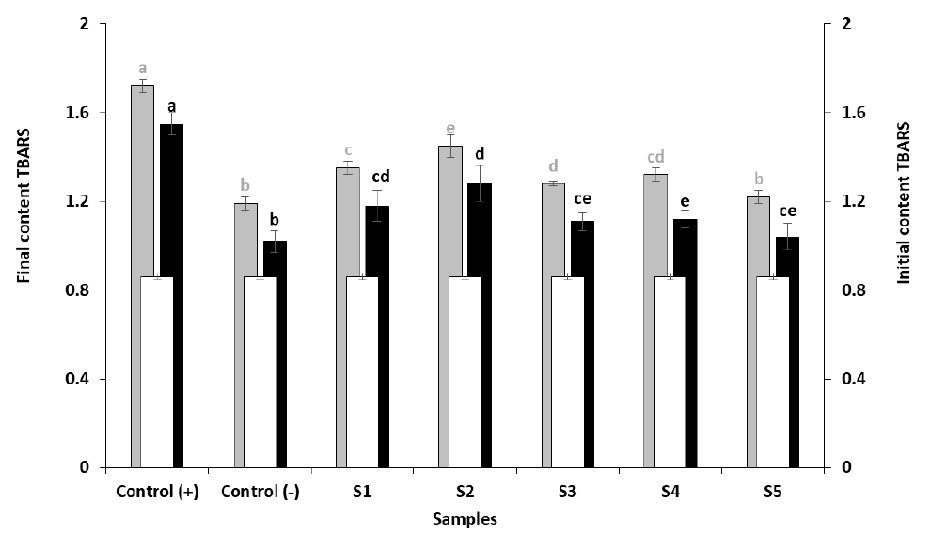
Figure 3. Thiobarbituric acid reactive substances (TBARS) content (mg malondialdehyde (MDA)/kg) in salmon burgers at the beginning of the experiment ( □ ) after refrigeration storage at 4 °C ( ■ , gray letters) and after refrigeration storage at 4 °C and cooking ( ■ , black letters). See Table 1 for details of the antioxidant composition in burger samples. Different letters mean significant differences between burger groups before and after cooking (mean ± SD).